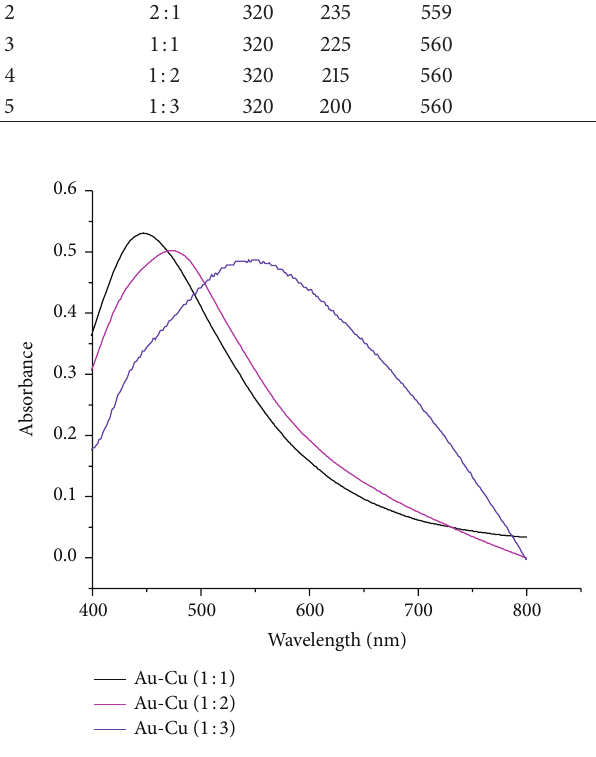
Figure 3: UV-Visible spectra of Au-Cu (1: 1), Au-Cu (1: 2), and Au- Cu (1: 3) nanoparticles showing bathochromic shift with increase in composition of Cu in Au-Cu alloy nanoparticles.